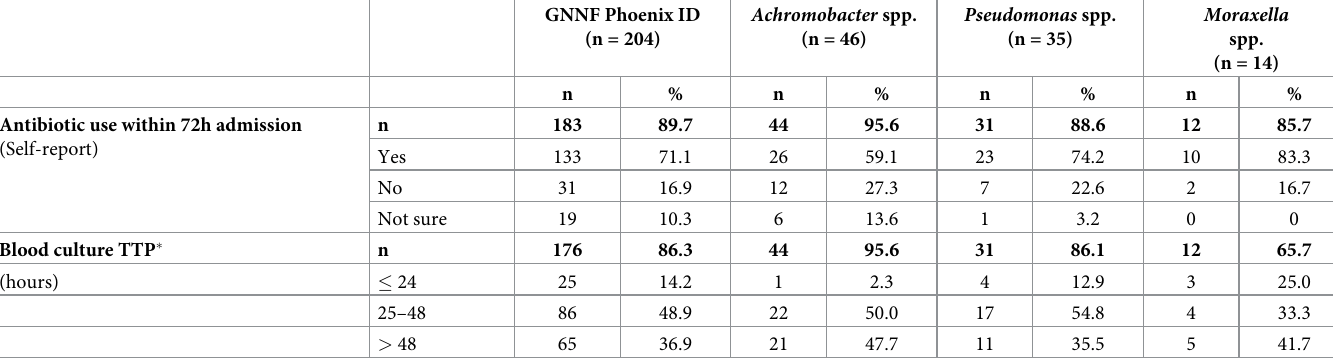
counted 69.5% (1,386,621/ 1,994,443) classified reads as belonging to the Acinetobacter genus. Table 2. Summary of patient antibiotic use prior to admission and time-to-positivity (TTP) for blood